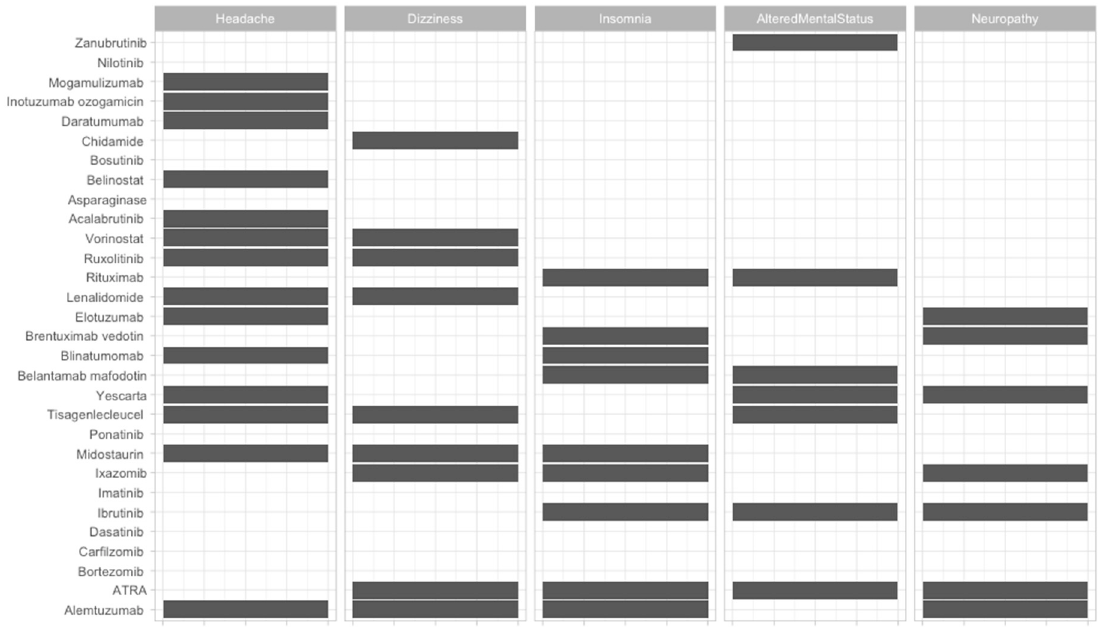
Figure 3. Neurologic side-effects of FDA-approved and non-approved drugs for hematological disorders.